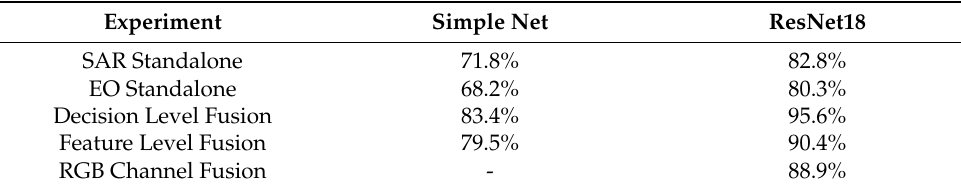
Table 1. Average overall classification accuracies of each fusion